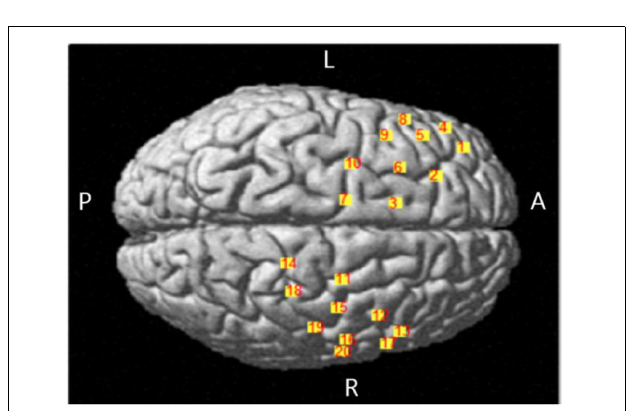
FIGURE 3 | Location map of brain projection of each